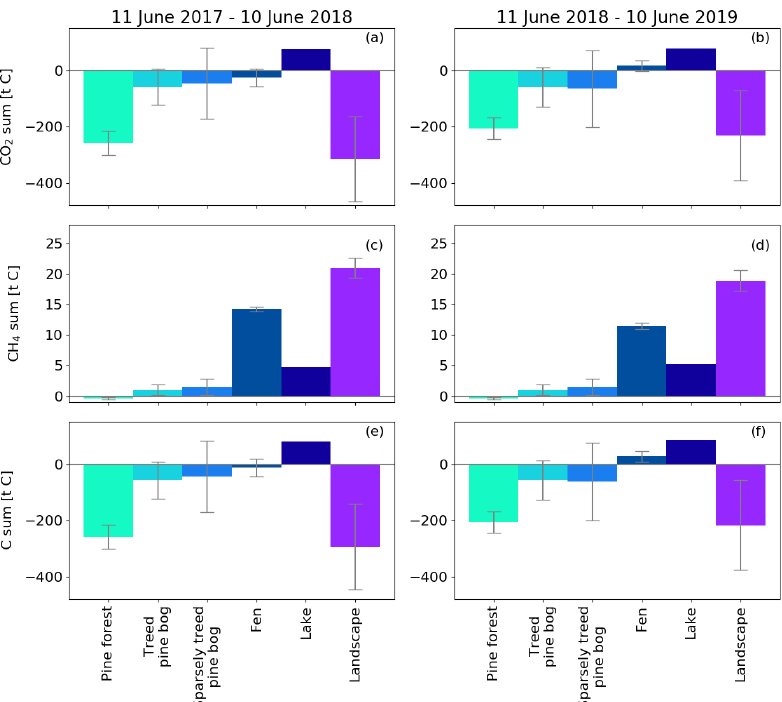
Figure 14. Annual CO 2 , CH 4 , and C flux sums for different ecosystems and the landscape (Fig. 1) upscaled with the corresponding area. The CH 4 flux estimate for forest is from Dinsmore et al. (2017) and for pine bog from Bubier et al. (2005). The error bars denote the 95% confidence interval. Uncertainty estimates were not available for the modelled lake balances (Kou et al.,